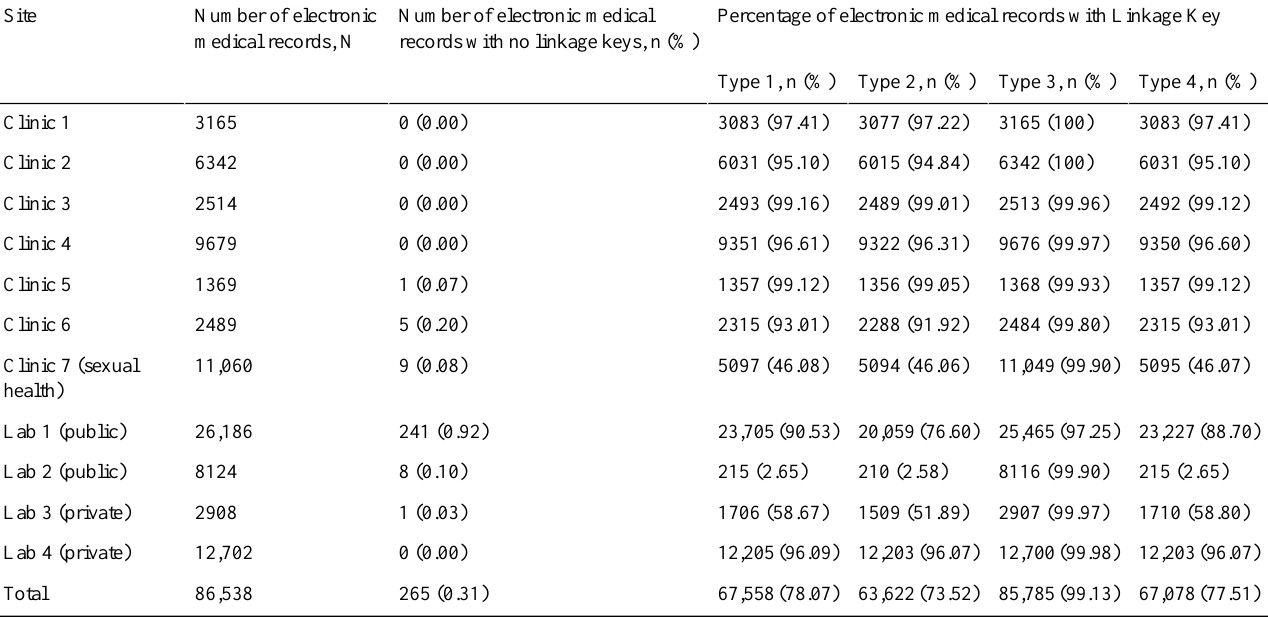
Percentage of electronic medical records with Linkage KeyNumber of electronic medical